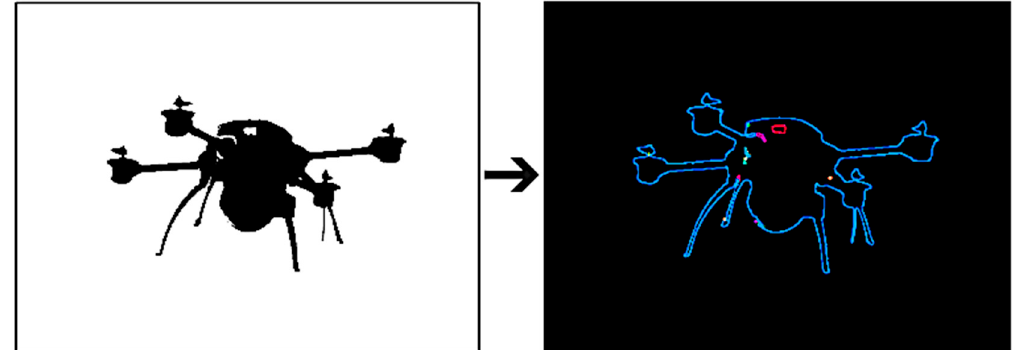
Figure 1. Contour searching applied to the edited image with a drone .